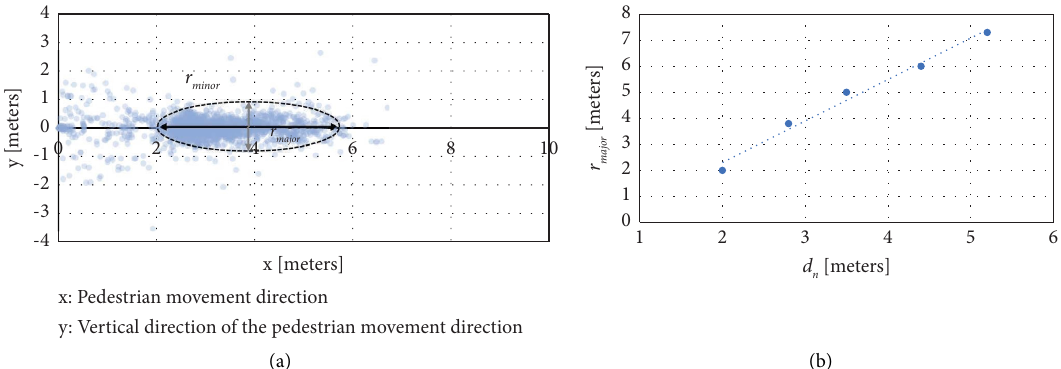
Figure 4: Pedestrian future reachable area: (a) estimated ellipse major and minor axes from plotted pedestrian trajectory data and (b) according to d n modeled r major